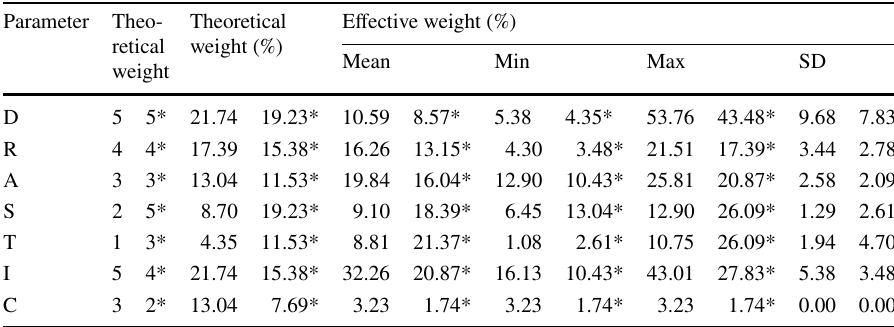
* Values for Pesticide